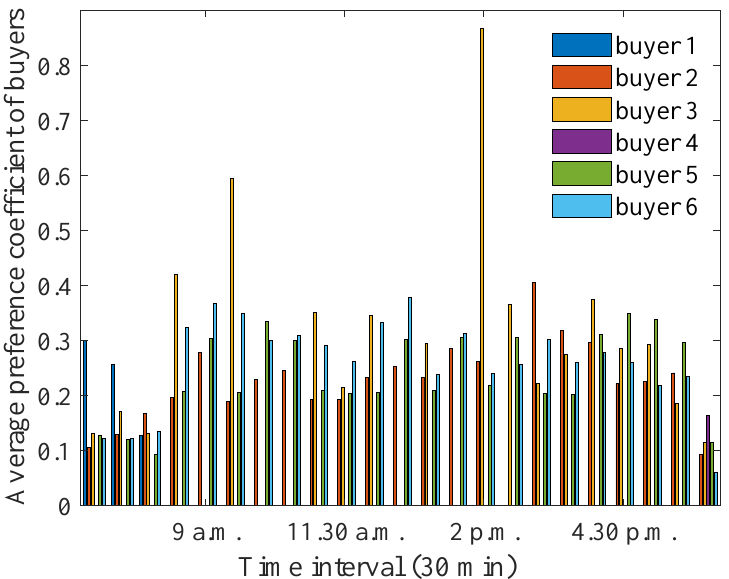
Figure 30. Optimum preference coefficients for buyers when profit threshold is increased to a larger